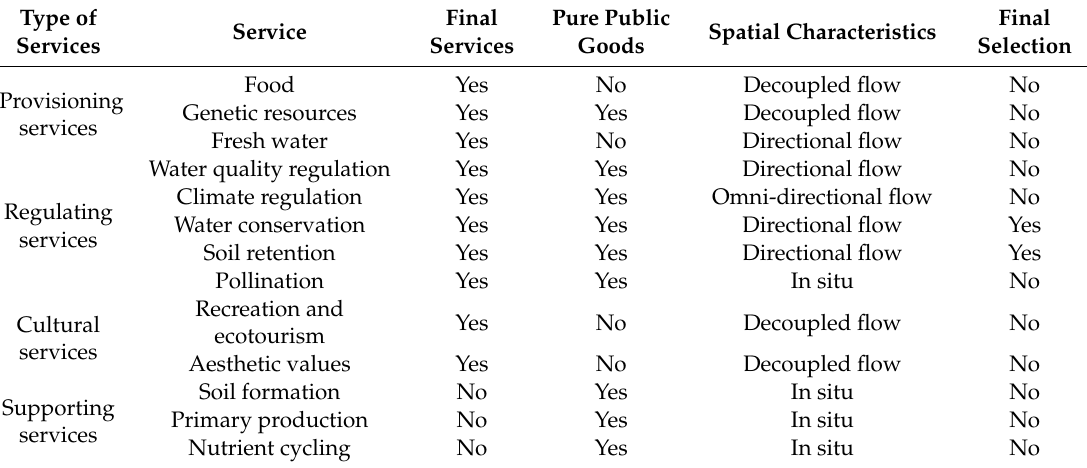
Table 1. The selection of the ecological compensation (ES).